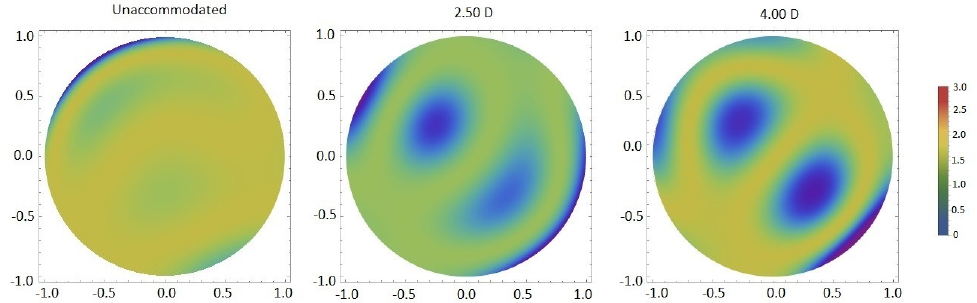
Figure 1. Wavefront aberration maps of total HOAs for three accommodative stimuli. Table 1. Methodological characteristics of articles where wavefront aberrations were measured during